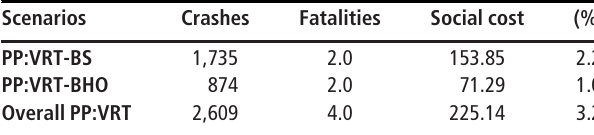
Table IX Crashes, fatalities and social cost of PP:VRT